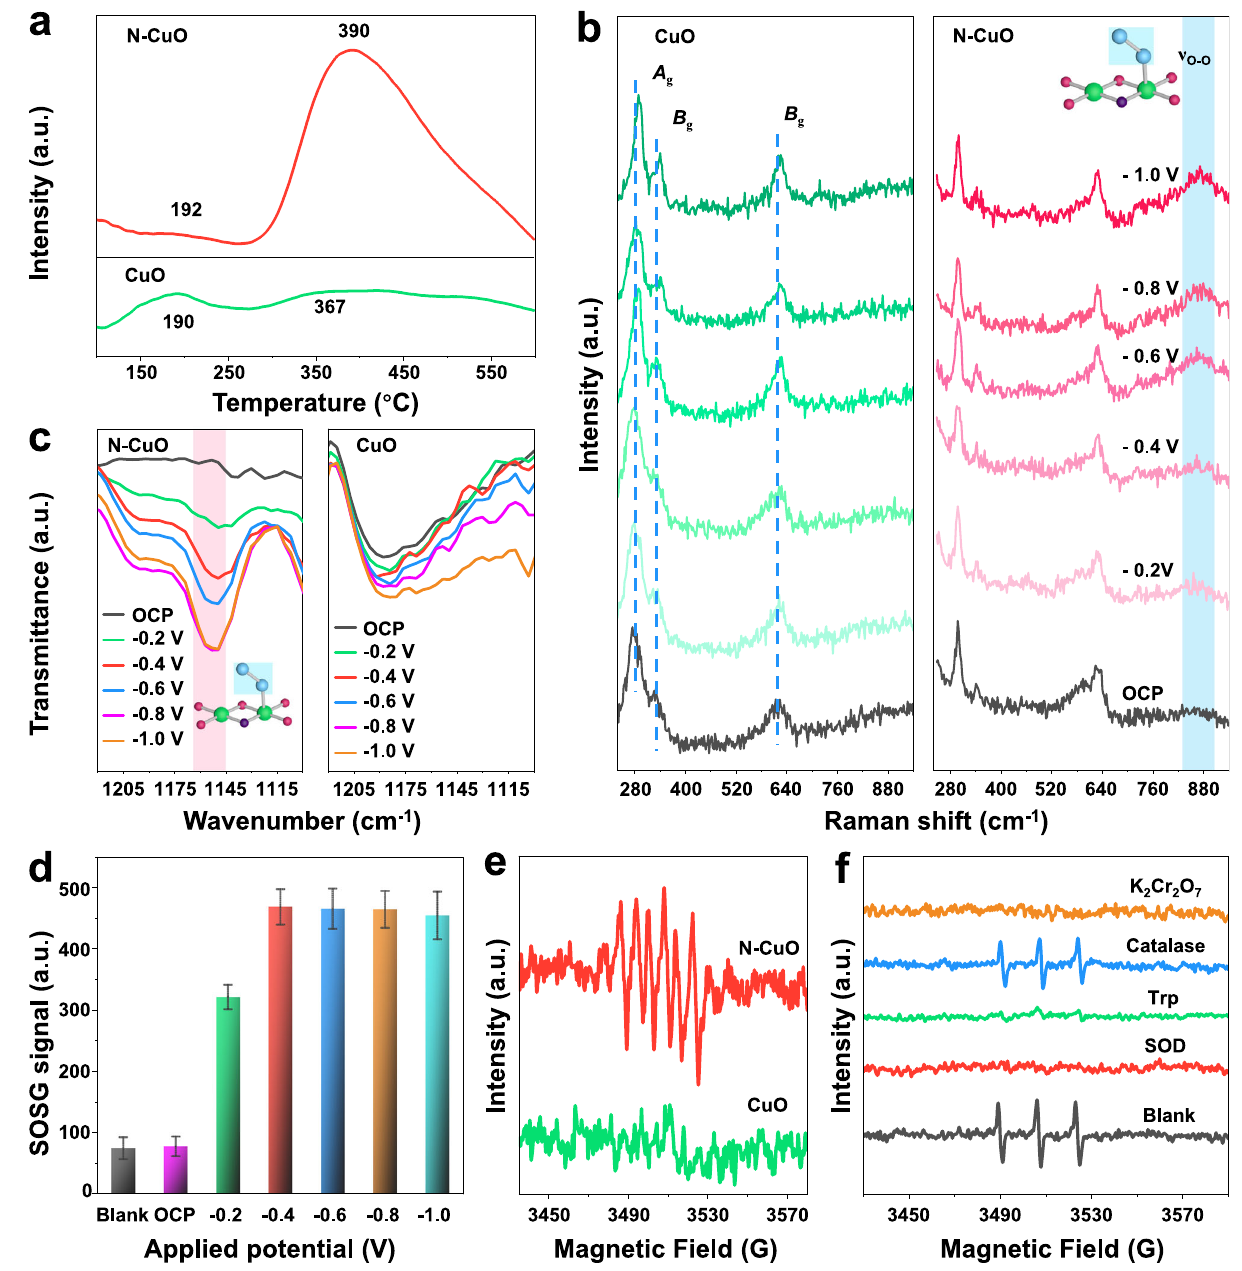
Fig.4|Themechanismfor 1 O 2 productionbytheelectrocatalyticprocessfrom of SOSG under different applied potentials in EC system. Error bars represent the